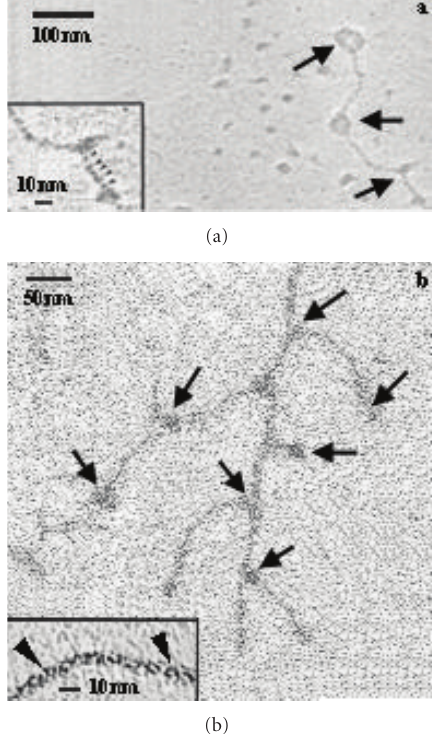
Figure 5: Mucin monomers are linked in a head-to-head manner in a mucous gel, which is a basis for forming a mucous gel. The inserts in (a) and (b) represent amplifications of a head-to-tail linkage (a node-like structure, (a)) or a mucin backbone (a twisted rope-like structure,